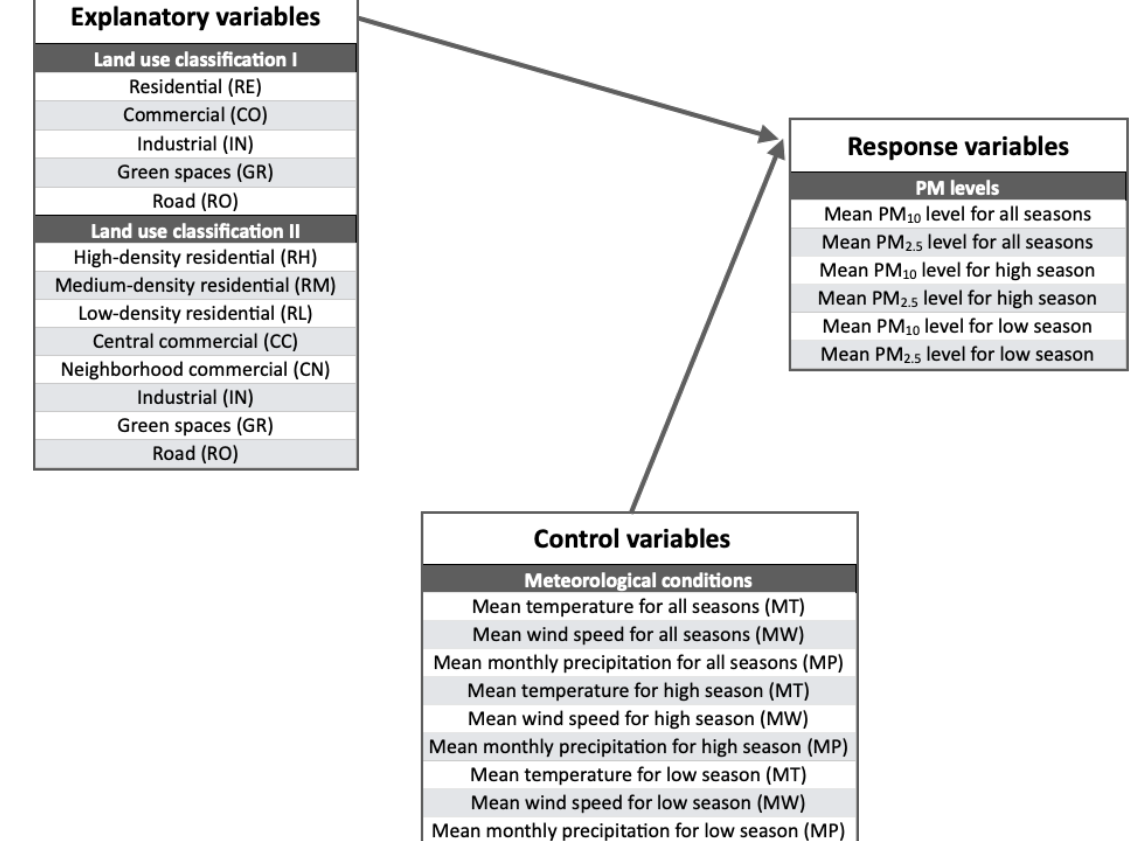
Figure 2. Explanatory, control, and response variables used in this study.